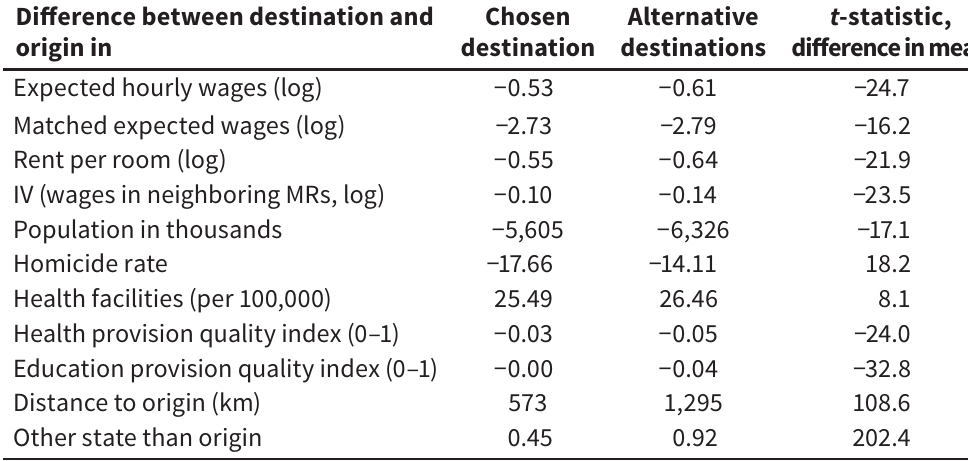
Difference between non-metropolitan destination and metropolitan origin comparing chosen destination to alternative